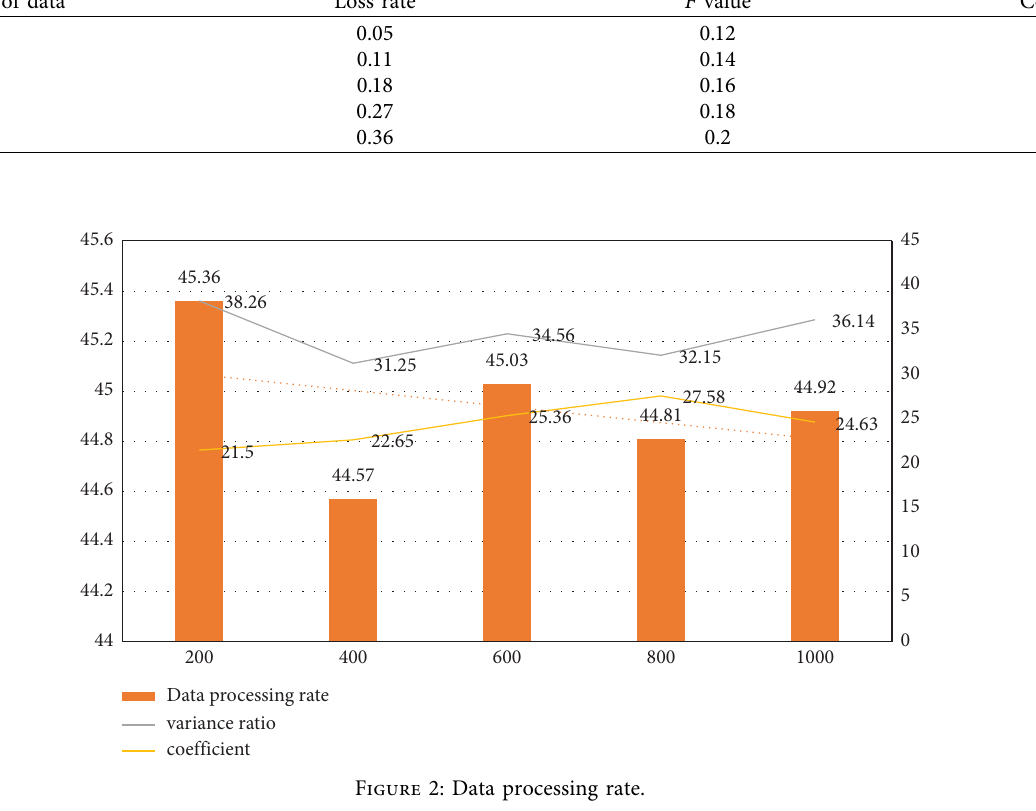
Figure 2: Data processing rate.